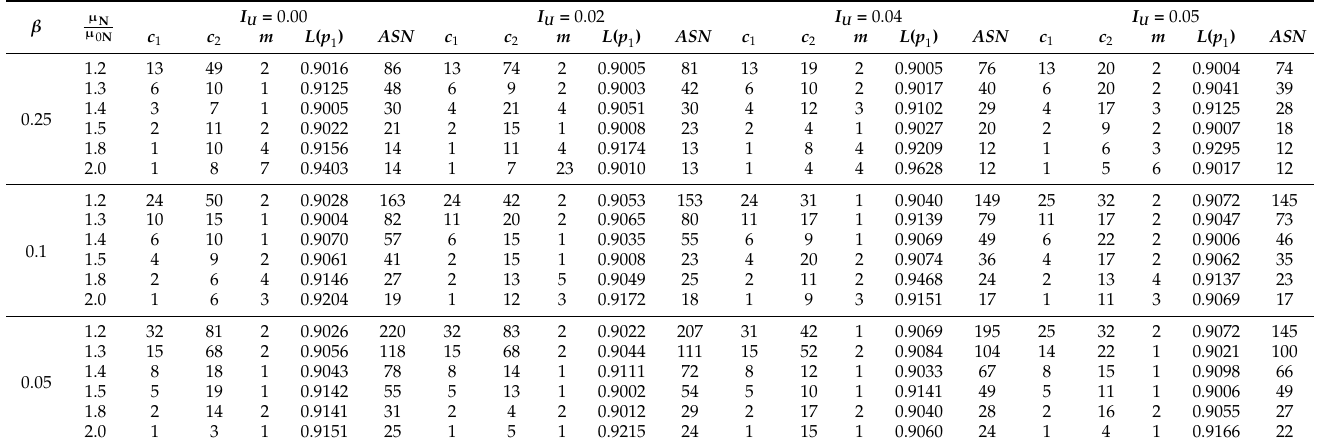
Table 5. The MDS design values for α = 0.10, ν = 3, and a = 0.50.